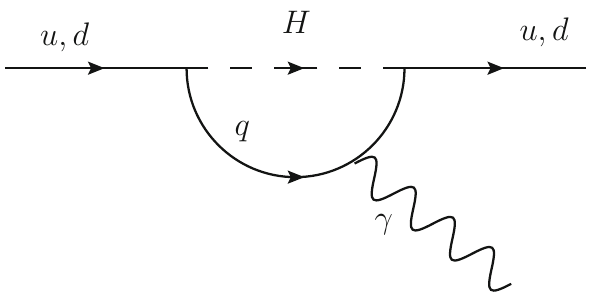
Fig. 1 OneloopdiagramsforEDMsof u -and d -quarkswithFCHiggs couplings. Here q = s , b for an EDM of the d -quark and q = c , t for an EDM of a u